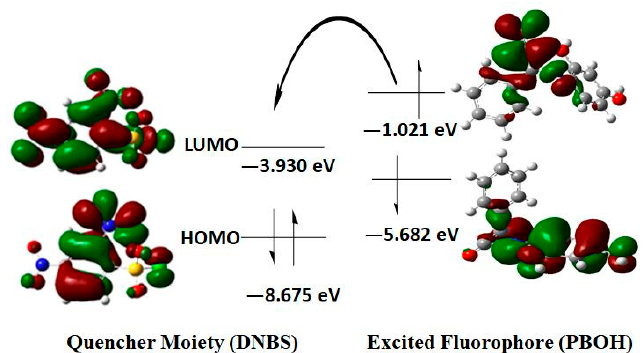
Figure 6. Frontier orbital diagrams of PBOH and 2,4-dinitrophenylsulfonyl (DNBS). Orbital energies were calculated using Gaussian 03 program at B3LYP/6-31 g (d, p) level.